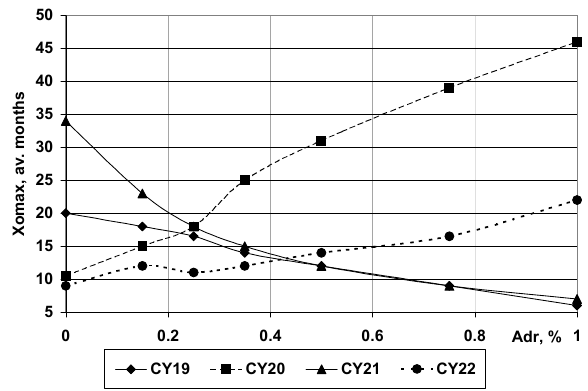
Table 1. Values of X o max (in av. months, bold) and correlation coefficients for observed data (0%) and corrected drift effects with different amplitudes, according to the third model.